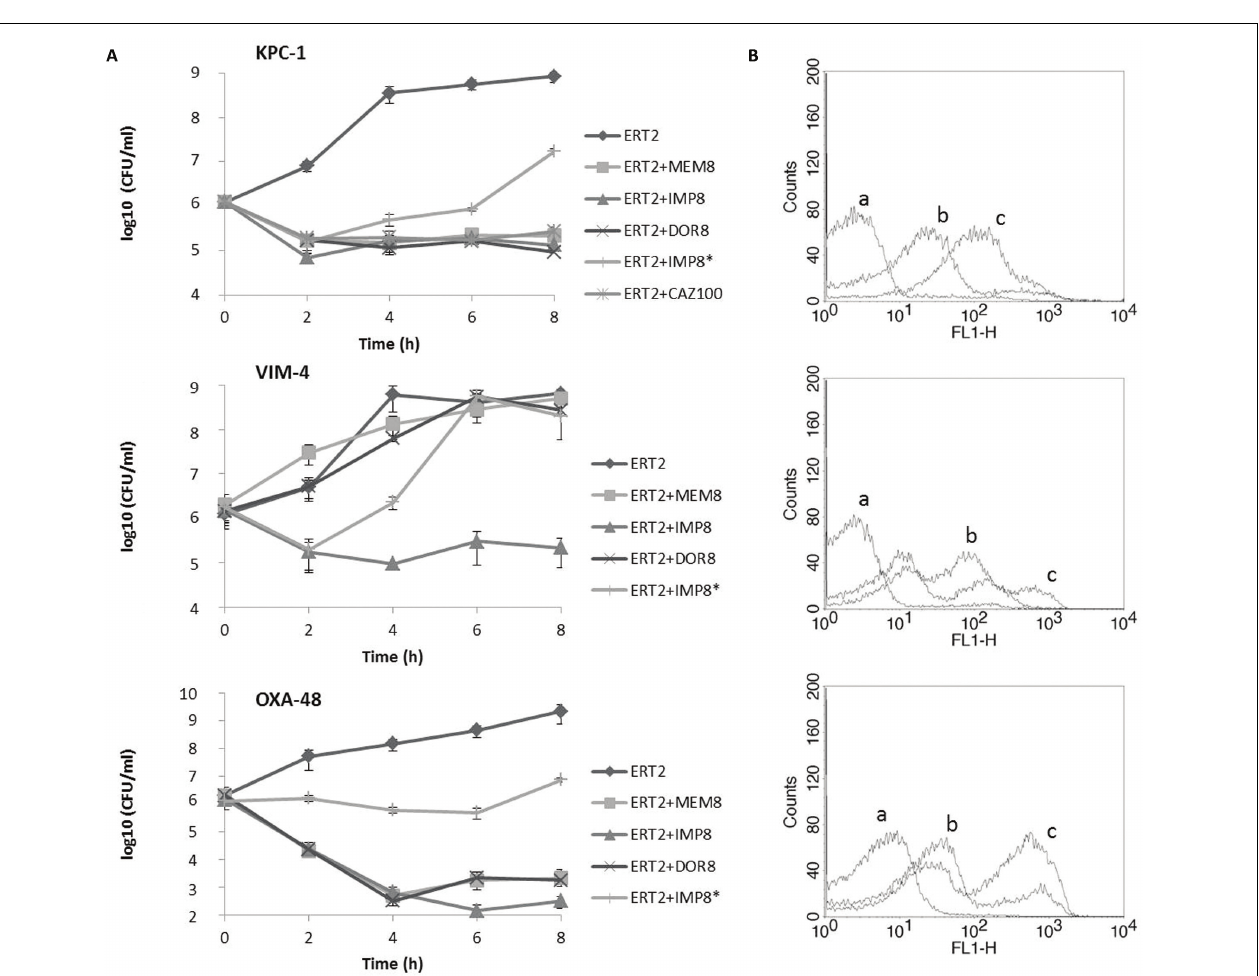
FIGURE 1 | (A) Time-kill curves of various antibiotic combinations against a strain of Klebsiella pneumoniae KPC-2, a strain of Enterobacter cloacae VIM-4, and a K. pneumoniae OXA-48. Each line represents ertapenem (ERT) either alone or associated with meropenem (MEM), imipinem (IMP), or doripenem (DOR) reinforced with the respective drugs each 2 h. Ertapenem plus imipenem ( ∗ ) is shown as an example of the treatment without reinforcement. The association of ERT 2 mg/L with ceftazidime (CAZ) 100 mg/L against KPC-2 producing bacteria is also represented. (B) Overlay of histograms obtained by flow cytometry. For each strain, cells stained with DiBAC4(3) are represented after 2 h treatment with ERT 2 mg/L (a), ERT 0.5 mg/L plus IMP 8 mg/L (b), and ERT 2 mg/L plus IMP 8 mg/L (c).